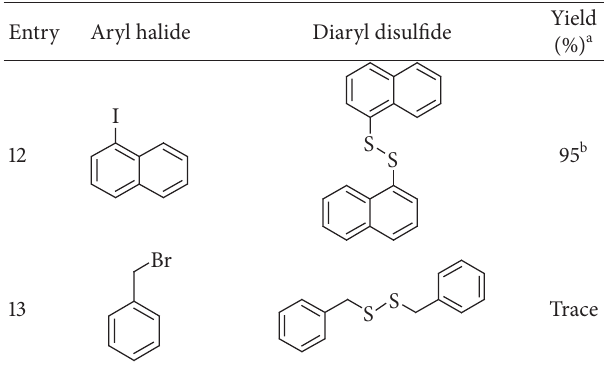
O mediated, direct synthesis of 2 3